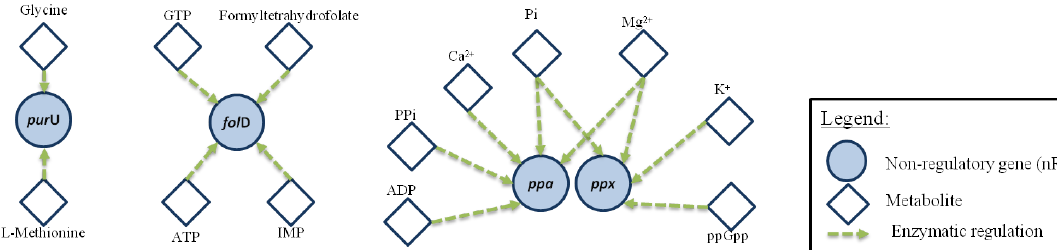
Figure 3: Examples of the short-term regulation affecting the “Folate Metabolism’ ( pur U and folD genes) and “Anaplerotic reactions’ ( ppa and ppx genes). In the “Folate Metabolism’, the enzymatic activity of formyltetrahydrofolate deformylase encoded by pur U is essentially controlled by two amino acids, glycine and L-methionine, while the fol D gene product is regulated by purine-related compounds (GTP, IMP and ATP) and formyltetrahydrofolate. Anaplerotic enzymes coded by ppa and ppx are phosphohydrolases playing an important role in energy metabolism and are mainly controlled by cations (Ca 2+ , Mg 2+ and K + ) and other phosphate-related